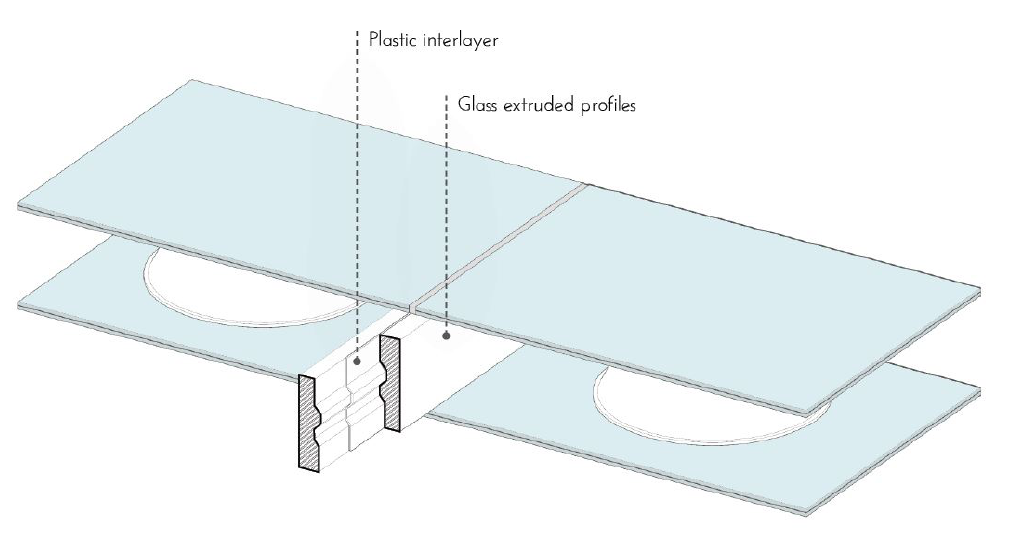
Fig. 19: Detail between 2 consecutive